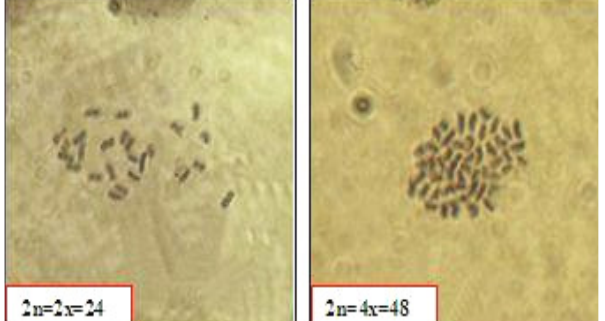
Fig. 5. Flow cytometric histograms of diploid (left) and tetraploid (right) Iranian mint